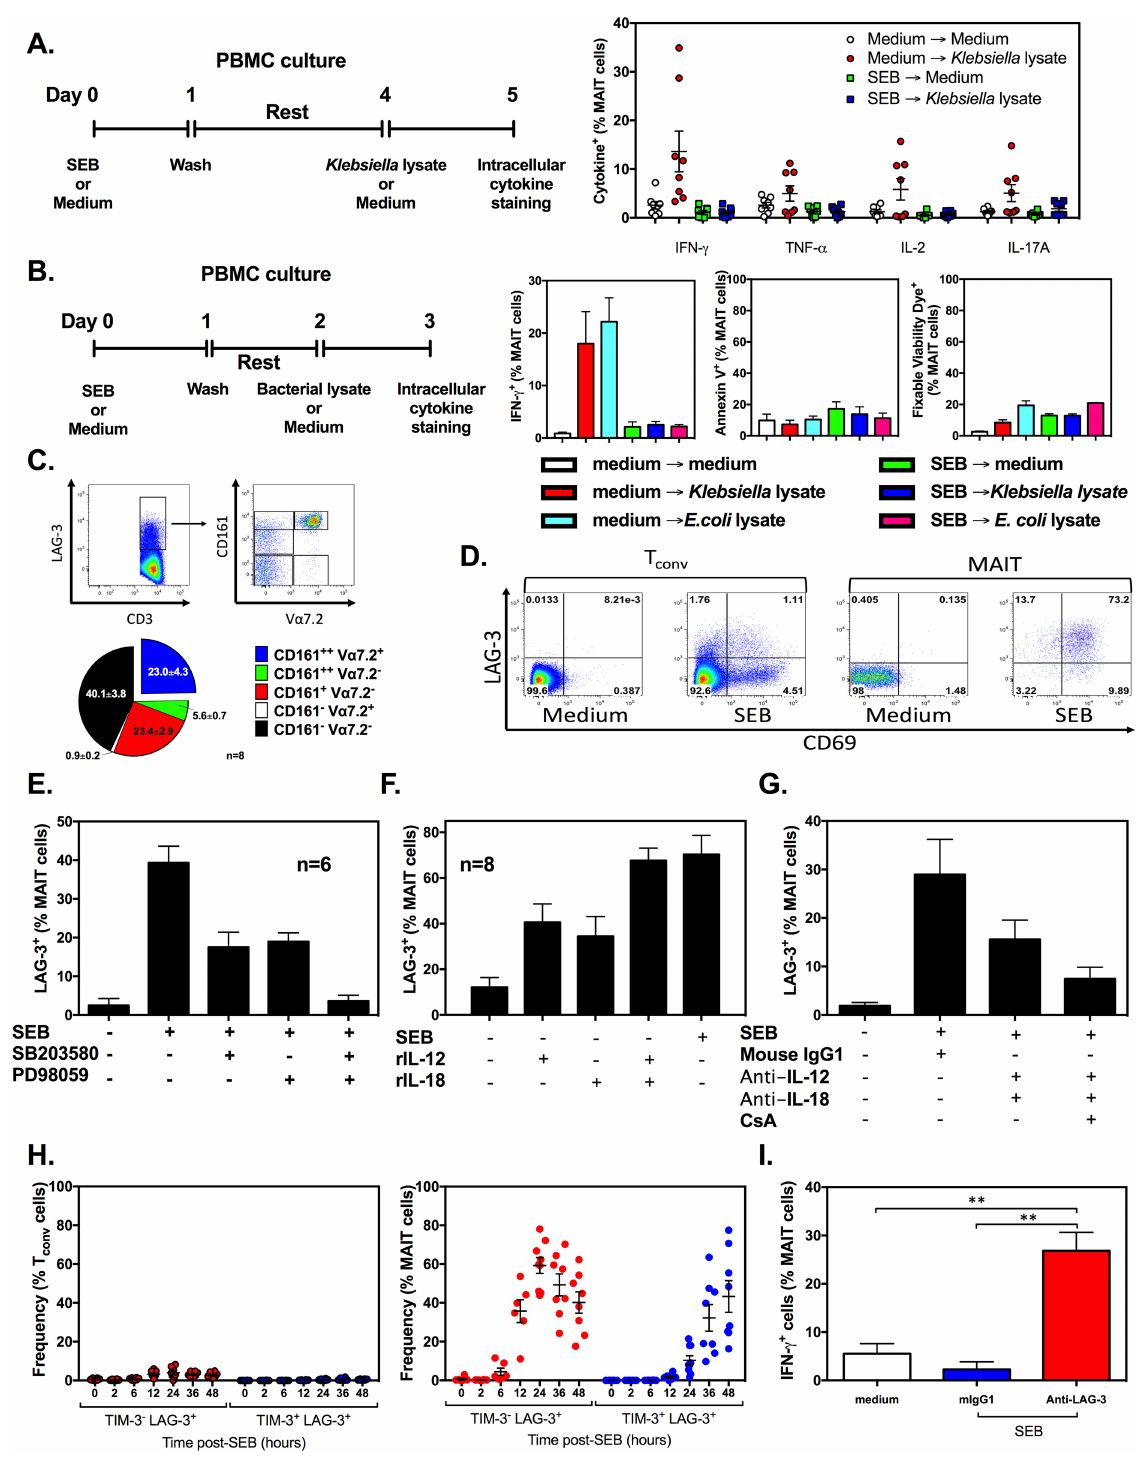
Fig 8. Staphylococcal enterotoxin B (SEB) stimulation of mucosa-associated invariant T (MAIT) cells results in lymphocyte-activation gene 3 (LAG-3)/ T cell immunoglobulin and mucin-3 (TIM-3) upregulation and interfereswith their cognate antibacterial activity. Human peripheral blood mononuclear cells (PBMCs) ( n = 8) were left untreated or stimulatedfor 24 h with SEB. They were then washedand rested for 3 days before they were exposedto K . pneumoniae lysate. Interferon (IFN)- γ + , tumor necrosis factor (TNF)- α + , interleukin(IL)-2 + , and IL-17A + events amongMAIT cells were enumerated 24 h later by